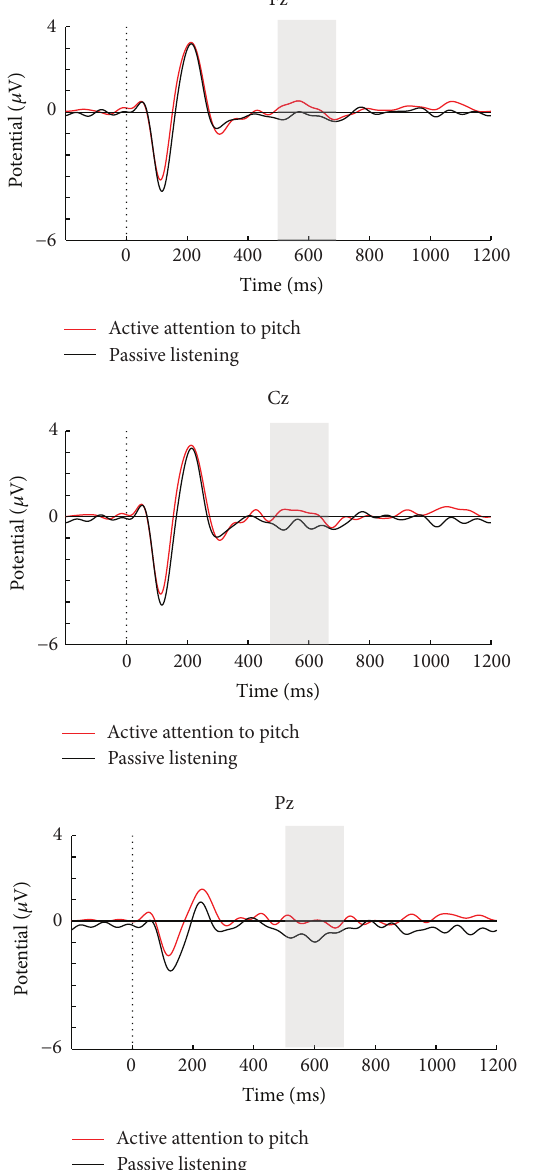
Figure 3: Passive and active conditions in task 1 for the healthy controls.